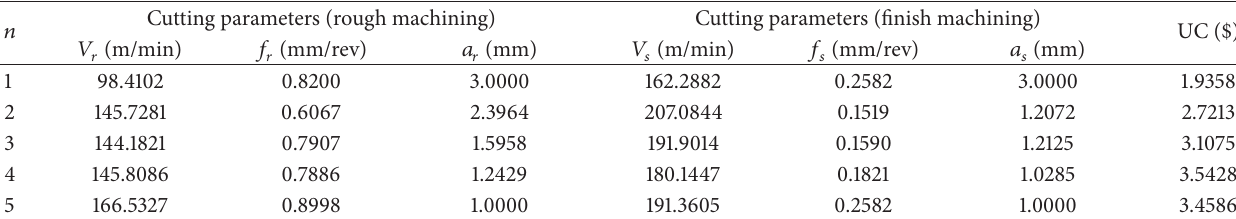
Table 2: The optimized turning parameters.